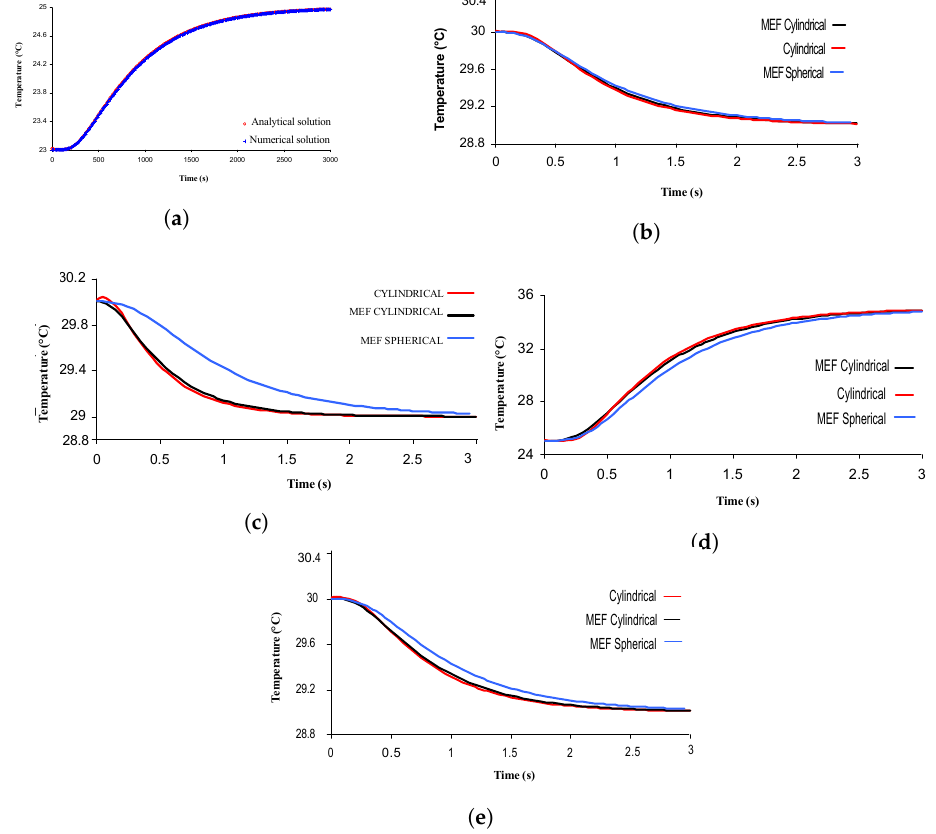
Figure 3. Comparison between analytical and numerical solutions for: ( a ) the centroid of a cylinder, located at a radius of 0.0 cm and a height of 3.71 cm with properties of the water; ( b ) a cylinder with a radius of 2.2 cm and a height of 4.5 cm, compared with the sphere with a 2.5 cm radius; ( c ) a cylinder with a radius of 1.5 cm and a height of 9.9 cm, compared with the sphere with a 2.5 cm radius; ( d ) a cylinder with a radius of 2.2 cm and a height of 4.5 cm, compared with the sphere with a 2.5 cm radius; ( e ) the initial condition of 25 ◦ C and the boundary condition of T c = 35 ◦ C for a cylinder with a radius of 2.2 cm and a height of 4.5 cm, compared with the sphere with a 2.5 cm